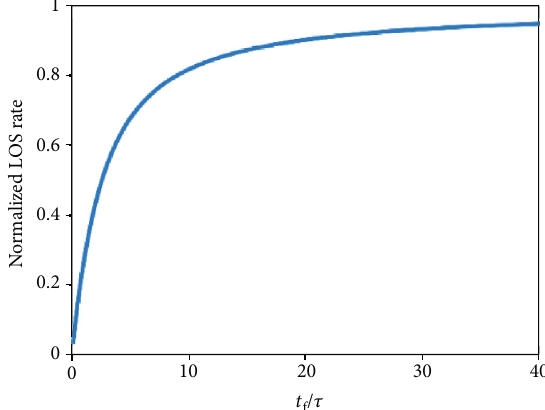
Figure 6: The upper bound of the normalized LOS rate in two- dimensional